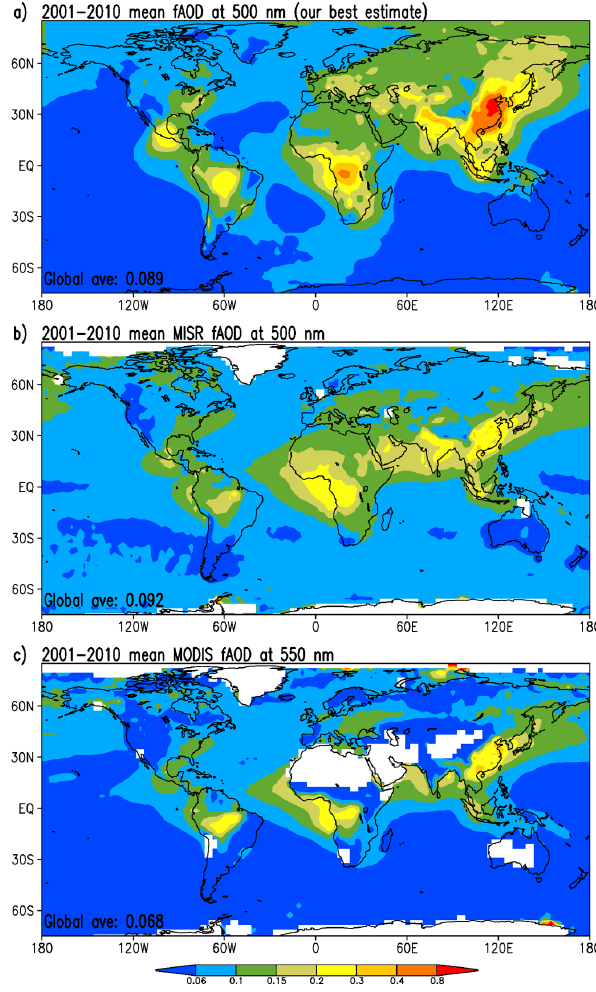
Fig. 7. Fine-mode AOD (fAOD) estimated by: (a) our best integra- tion method; (b) MISR fAOD; and (c) MODIS fAOD.